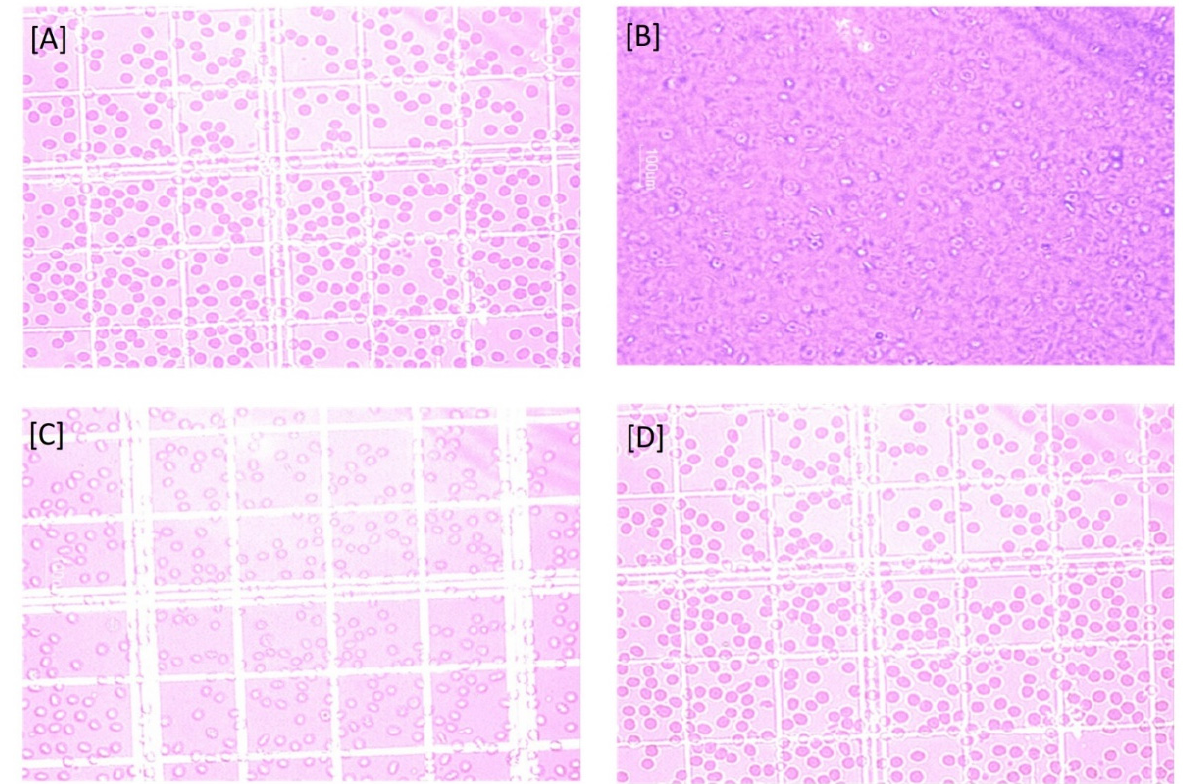
Figure 6. Erythrocytes on interaction with ( A ) Saline solution, ( B ) Water, ( C ) Pure drug solution, and ( D ) Nanogel formulation.